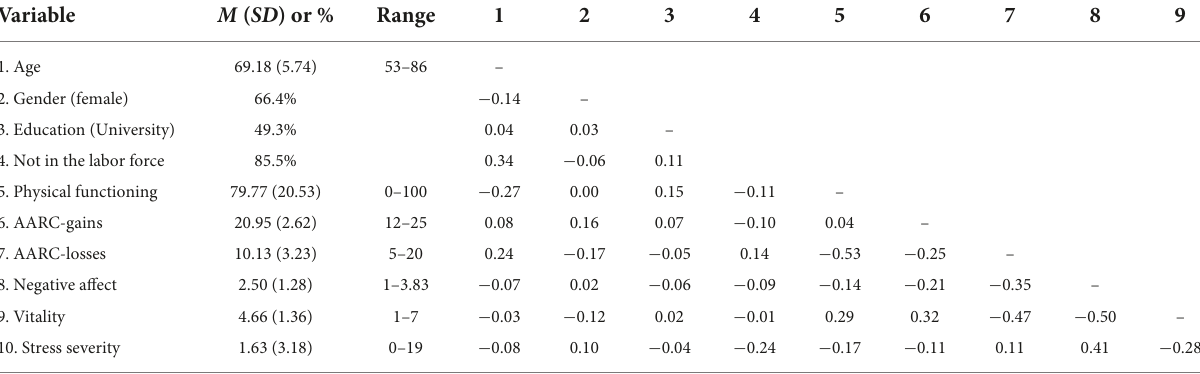
TABLE 1 Descriptive statistics (at Day 1) and correlations of AARC, stressors, affect, and control variables (data in long-form).